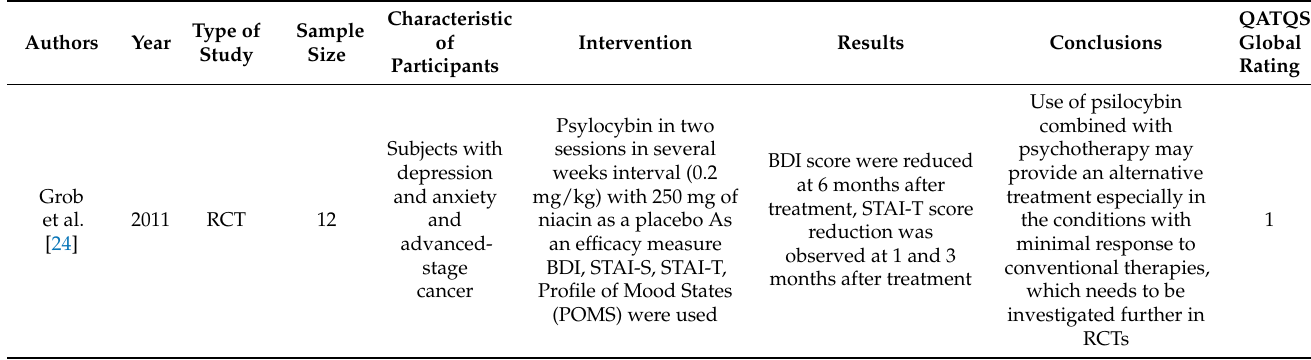
Table 1. Summary of clinical studies evaluating the antidepressant effect of psilocybin ( n = 6). The abbreviations are explained in the